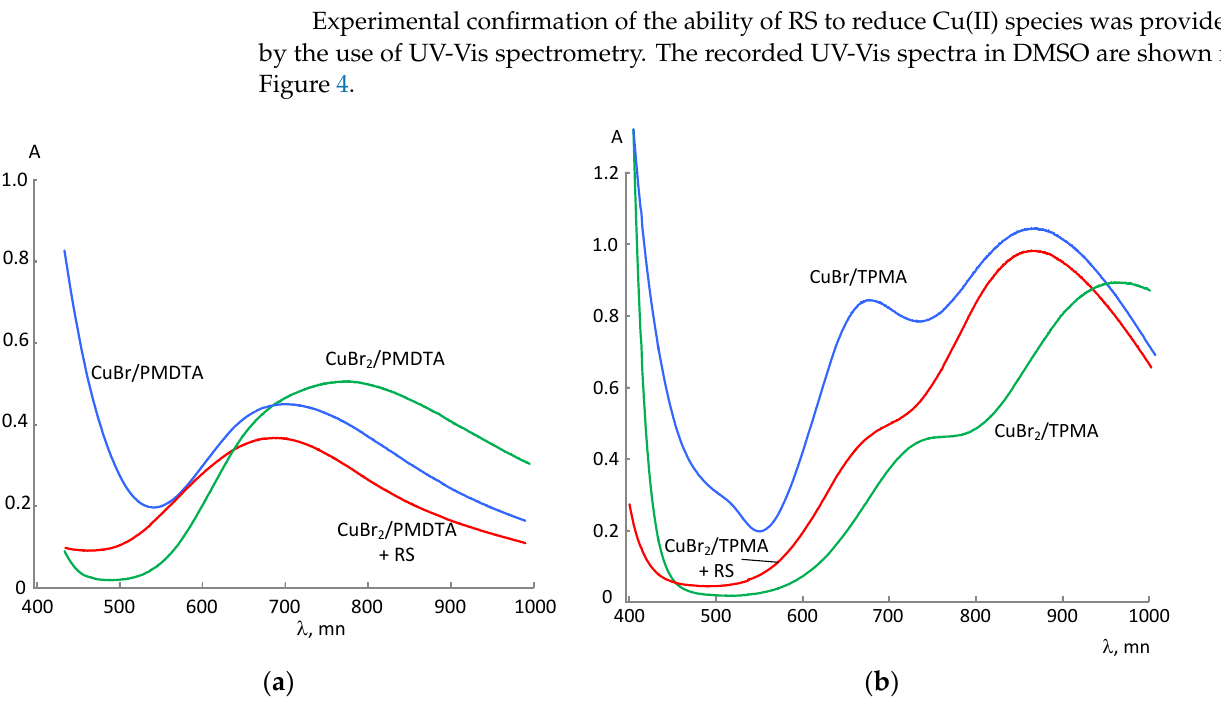
Figure 4. The UV-VIS spectra of DMSO solutions of copper complexes in DMSO. [Cu] = 0.005 M, [ligand] = 0.0075 M, [RS] = 0.05 M. T = 25 °C: ( a ) Complexes with PMDTA; ( b ) Complexes with TPMA.